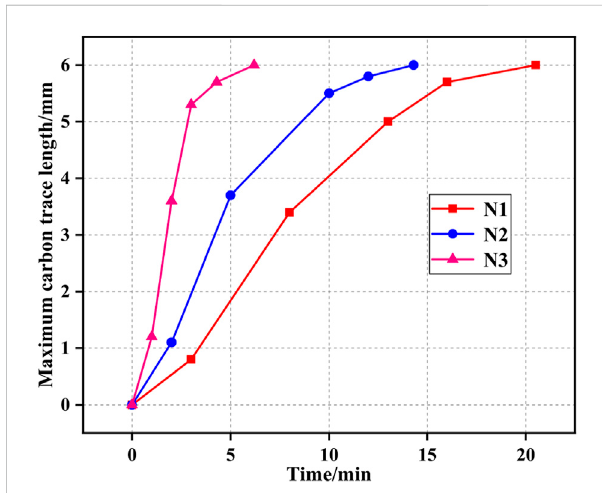
FIGURE 10 Trendof maximum carbon tracelength with time underdifferent carbon particle concentrations.